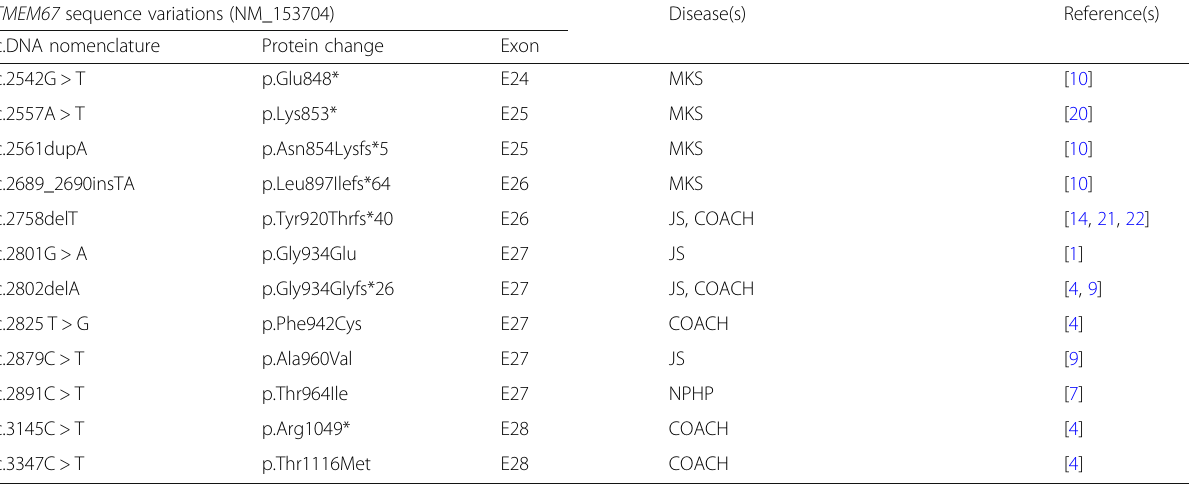
Table 1 TMEM67 sequence variations associated with a wide phenotype spectrum previously reported in the medical literature (Continued) TMEM67 sequence variations (NM_153704)